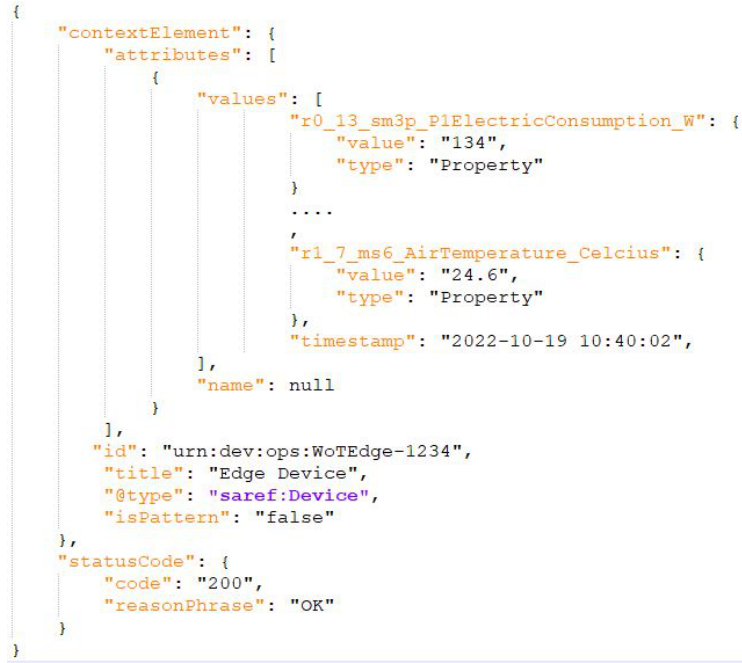
Figure 14. Example of JSON